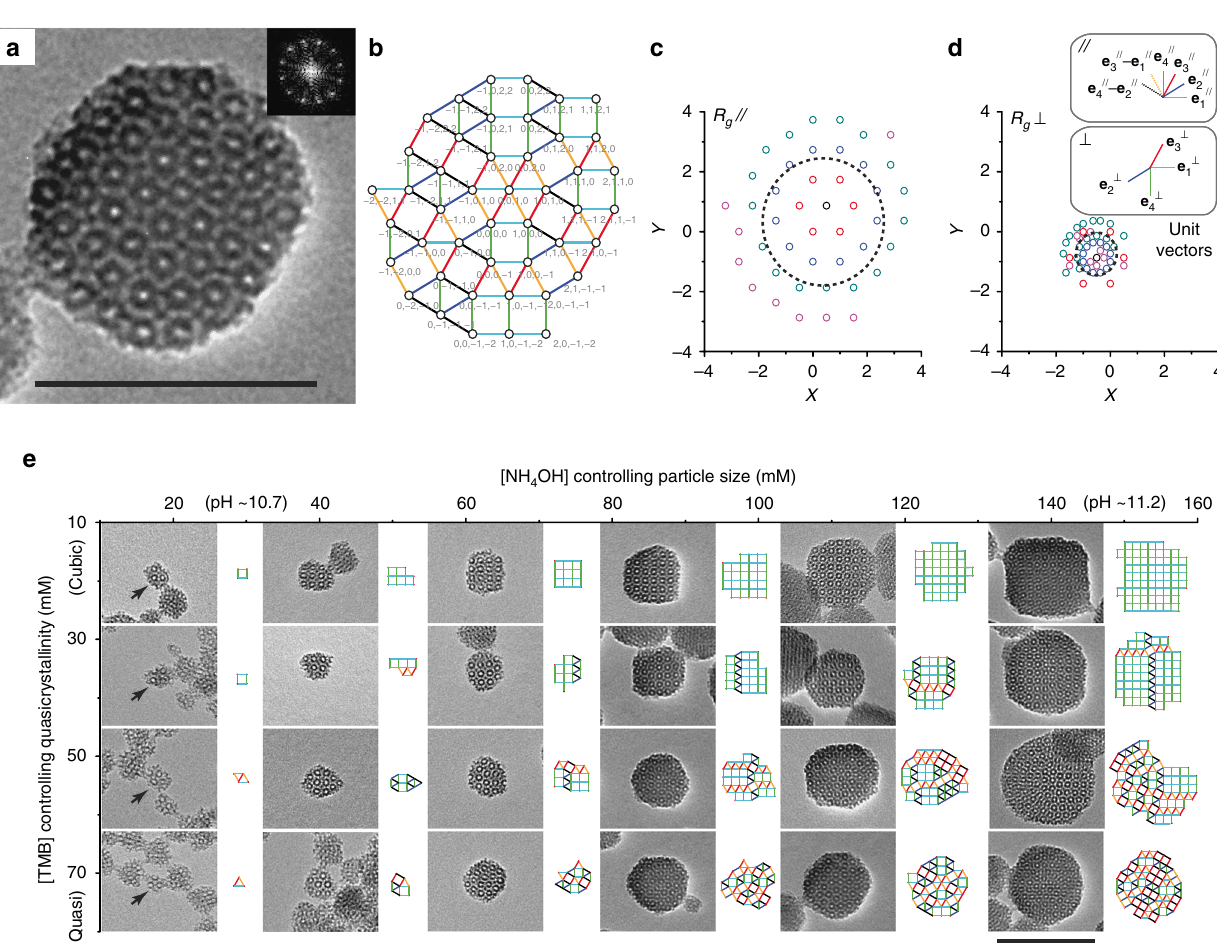
Fig. 2 Quasicrystallinity of TMOS/APTMS-derived MSNs. a TEM image of a MSN with dodecagonal symmetry, synthesized using TMOS and APTMS. The scale bar is 100 nm. The insert in a shows a diffractogram of the TEM image exhibiting 12-fold symmetry. b Square-triangle tiling and parallel space coordinates of the nanoparticle shown in a . Edges with different colors correspond to the six dodecagonal directions in parallel space. The corresponding dodecagonal directions in parallel and perpendicular space are shown in d . c , d Parallel and perpendicular space coordinates for the triangle-square tiling shown in b . Dotted circles with radius equal to R g // and R g ⊥ are shown on the parallel and perpendicular space plots, respectively. The colors in c and d show how individual points move during the transformation. e TEM images and corresponding square-triangle tilings of representative MSNs ( arrows ) synthesized from different concentrations of mesitylene (TMB) and ammonium hydroxide (NH 4 OH). The stirring rate was 600 rpm for all syntheses. All images have the same magni fi cation; scale bar is 100